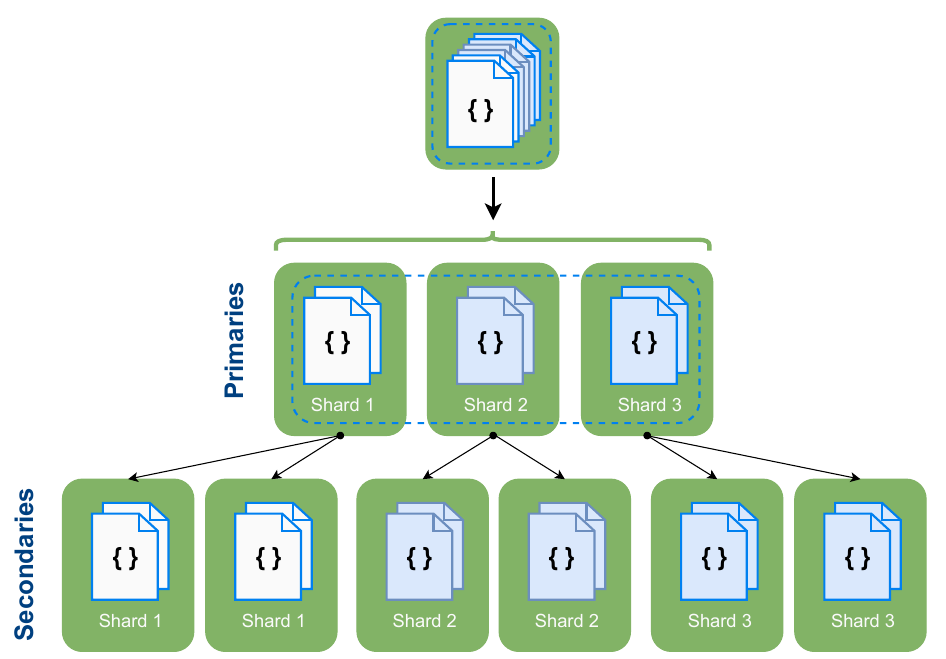
Figure 5. Cluster sharding plus replication